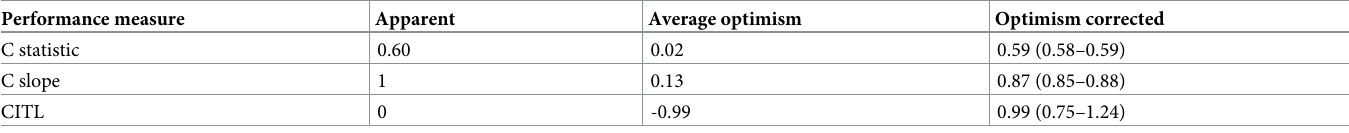
Table 5. Apparent and internal validation performance statistics of the simplified prediction model (with 95% CI) including C statistic, Calibration slope and Cali- bration-in-the-large. Performance